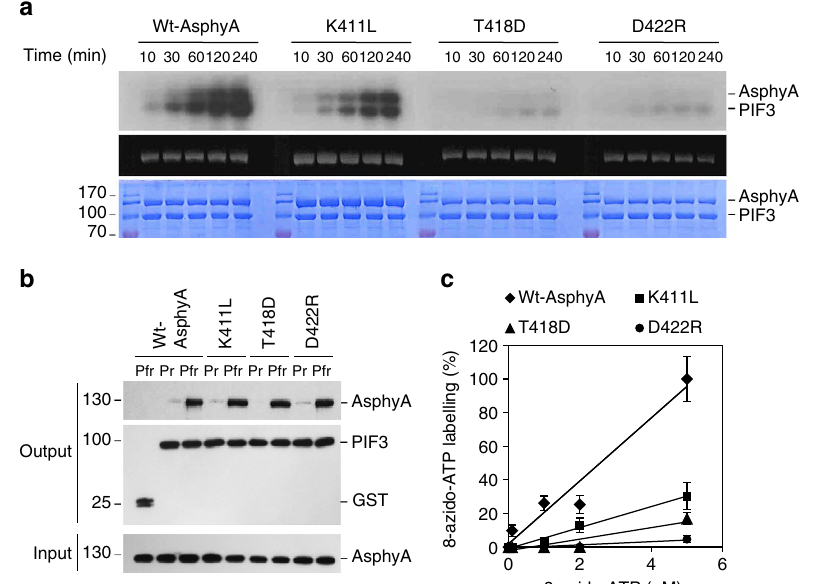
Figure 4 | Phosphorylation analyses of AsphyA mutants with reduced kinase activity. ( a ) Kinase activity assays of the AsphyA mutants. In all, 1.0 m g of GST/strep-fused PIF3 ( B 0.3 m M) was added as a substrate in reaction mixtures with 1.0 m g of either full-length WT or a mutant (K411L, T418D or D422R) AsphyA protein ( B 0.2 m M). ( b ) Protein–protein interaction analysis between PIF3 and the AsphyA kinase mutants. GST was included as a negative control. ( c ) ATP-binding affinity assays of AsphyA kinase mutants using photoaffinity labelling with 8-azido-ATP. 1.0 m g of full-length AsphyA protein ( B 80nM) was labelled with the indicated concentrations of 8-azido-ATP. The percentages of 8-azido-ATP labeling were obtained where the labelling of WT AsphyA with 5 m M azido-ATP was assumed as 100%. Error bars represent s.d. from three independent